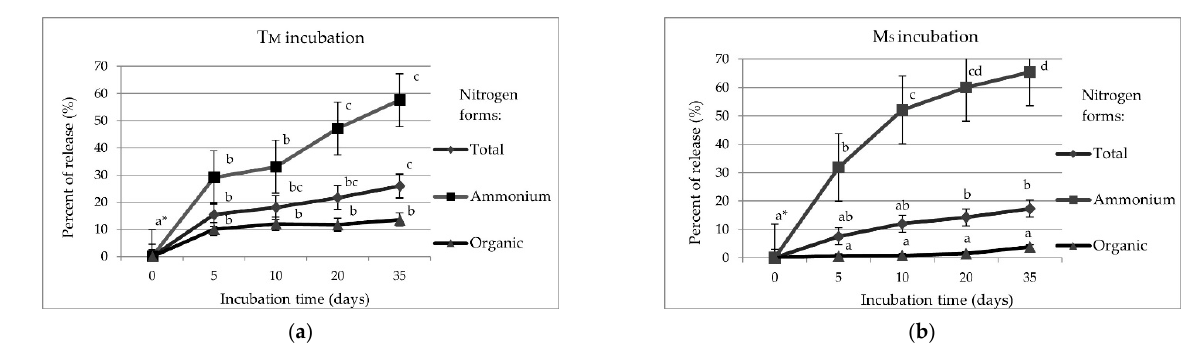
Figure 2. Effect of incubation time on cumulative released nitrogen under incubation of two organic pellets TM ( a ) and MS ( b ); values are mean ± standard error; * small letters indicate a significant difference (separate analyses were made for each form of nitrogen) from one another based on Tukey’s test at p < 0.05.